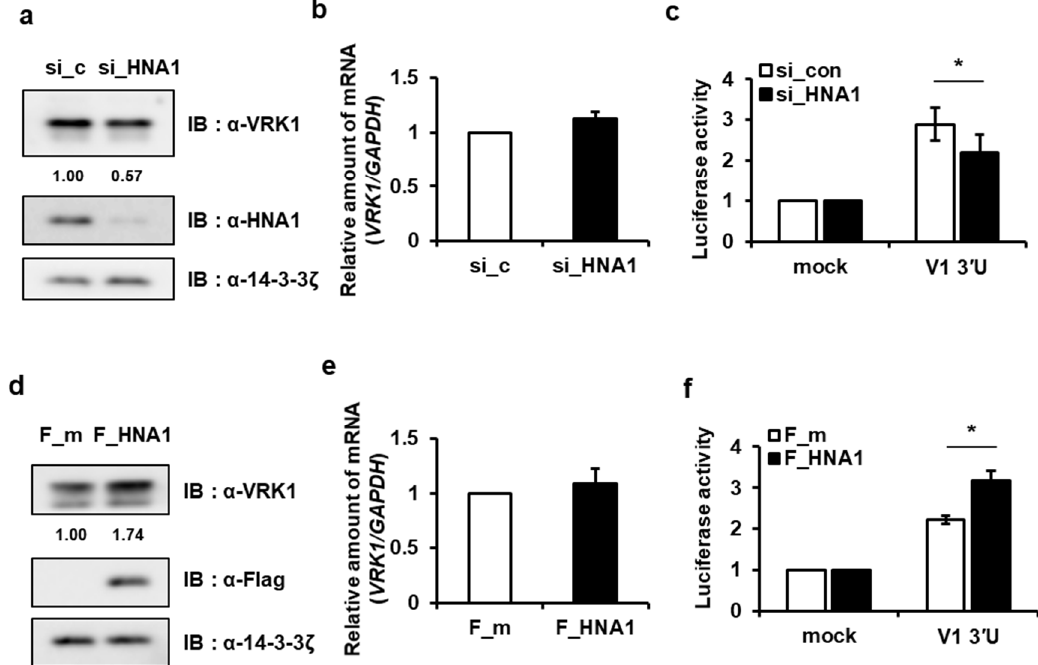
Figure 2. HNRNP A1 regulates the translation of VRK1 via its 3′UTR. ( a ) Immunoblots for HNRNP A1 and VRK1 in A549 cells at 36–48 h post-transfection of either control siRNA (si_c) or siRNA targeting HNRNP A1 (si_HNA1) are shown. 14-3-3ζ was used as a loading control. VRK1 protein abundance is decreased in HNRNP A1 knocked-down cells. ( b ) Levels of the VRK1 mRNA was measured by qRT-PCR. Values are means ± s.e.m. (unpaired two-tailed Student’s t -test, n = 3; n.s.,